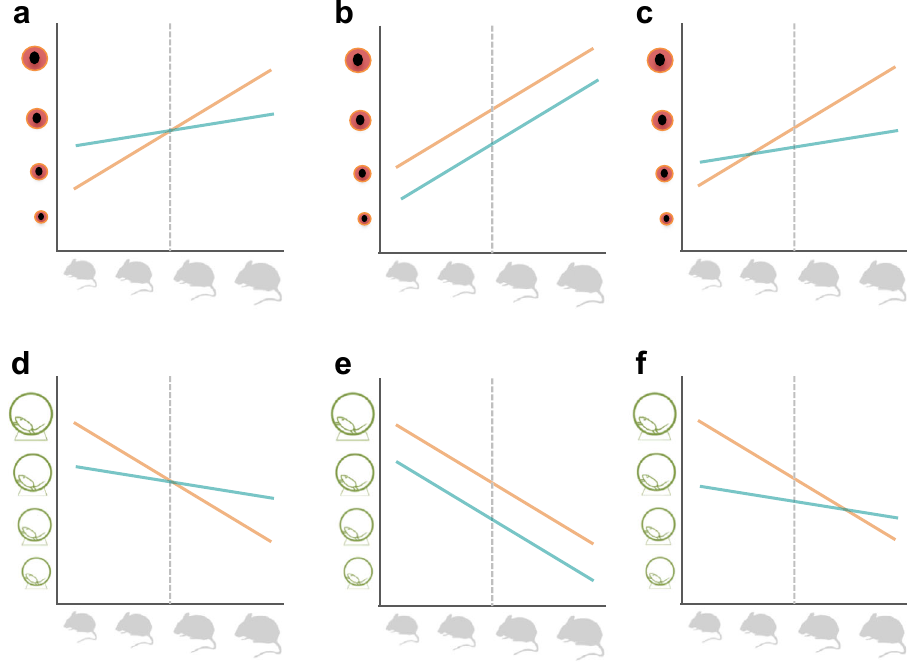
Fig. 1 | Examples of scenarios of sex differences in the allometric relationship between phenotypic trait and body weight. Top row shows a hypothetical positive relationship between body weight (x-axis) and eye size (y-axis) and the bottom row shows a negative relationship between body size and activity level (y- axis).Bodyweights are scaled and centred so thattheinterceptis atthetrait mean represented by a grey dashed line. A series of scenarios are illustrated as follows.